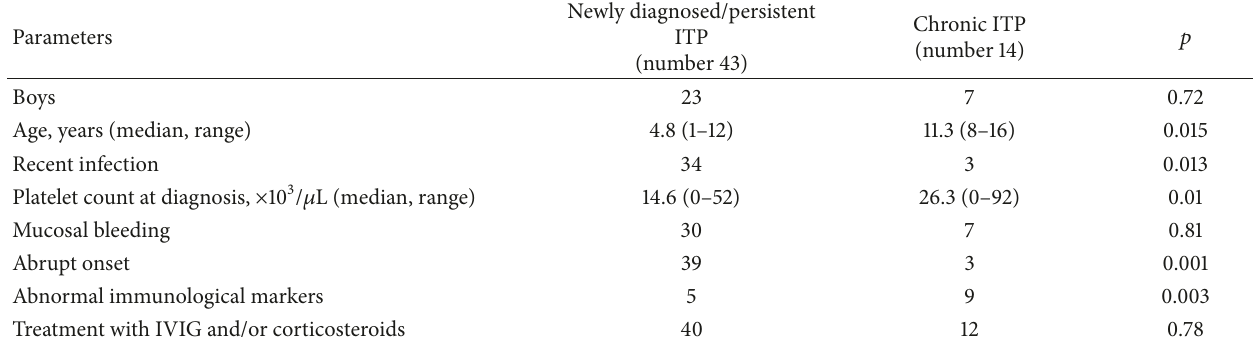
Table 1: Characteristics between different types of pediatric immune thrombocytopenia.